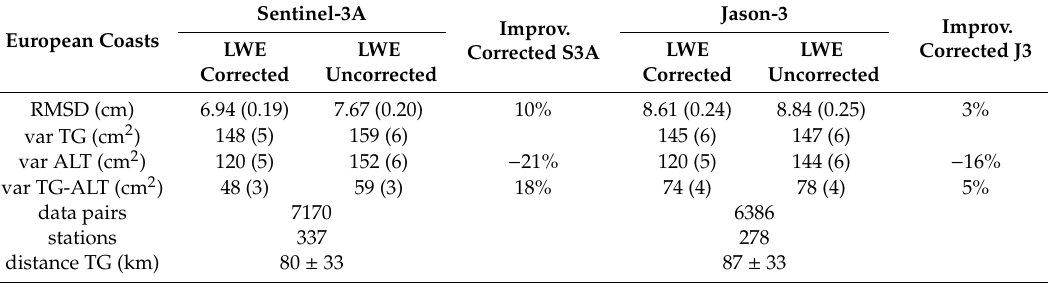
Table 5. Inter-comparison of the LWE-corrected and -uncorrected SLA from the Sentinel-3A and Jason-3 satellite missions and tide gauge data in the European coasts in terms of the RMSD (cm) and variance (cm 2 ) of the di ff erences between the datasets. The number of tide gauge stations used in the comparison, the mean distance between tide gauges and the most correlated along-track altimetry points, and the number of total data pairs (altimetry-tide gauge) used in the computation are displayed. The common tide gauge stations for each satellite mission have been used. Values in parentheses show the uncertainties (error bars) computed for the RMSD and variance from the bootstrap method using 10 3 iterations. Finally, the improvement (%) of the LWE-corrected SLA data from Sentinel-3A and Jason-3 in the comparison with tide gauges, in terms of the lower RMSD and lower variance of the di ff erences (altimetry-tide gauge) with respect to the LWE-uncorrected SLA data, is also displayed. SLA measurements without filtering have been